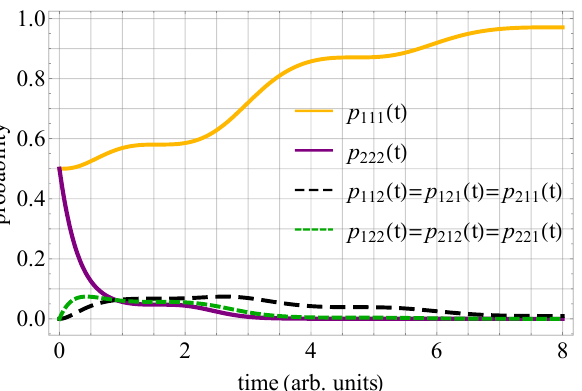
Figure 6. Plots present the probability of finding a three-qubit system in one of the possible states. The initial state is represented by